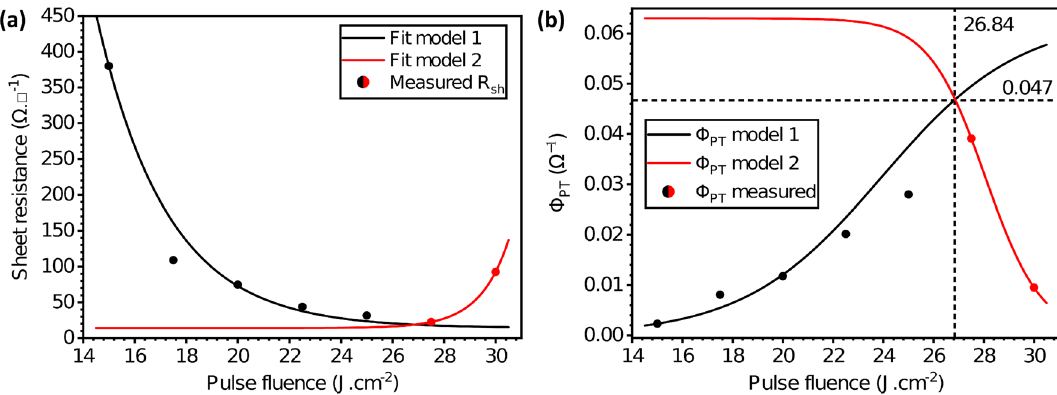
Figure 7. Figure-of-merit redefined for photonic treatment of transparent conductive electrodes (cid:31) PT . Dashed lines mark the highest value of the FoM corresponding to 0.0535 (cid:31) − 1 and a pulse fluence of F p = 26.4 J cm − 2